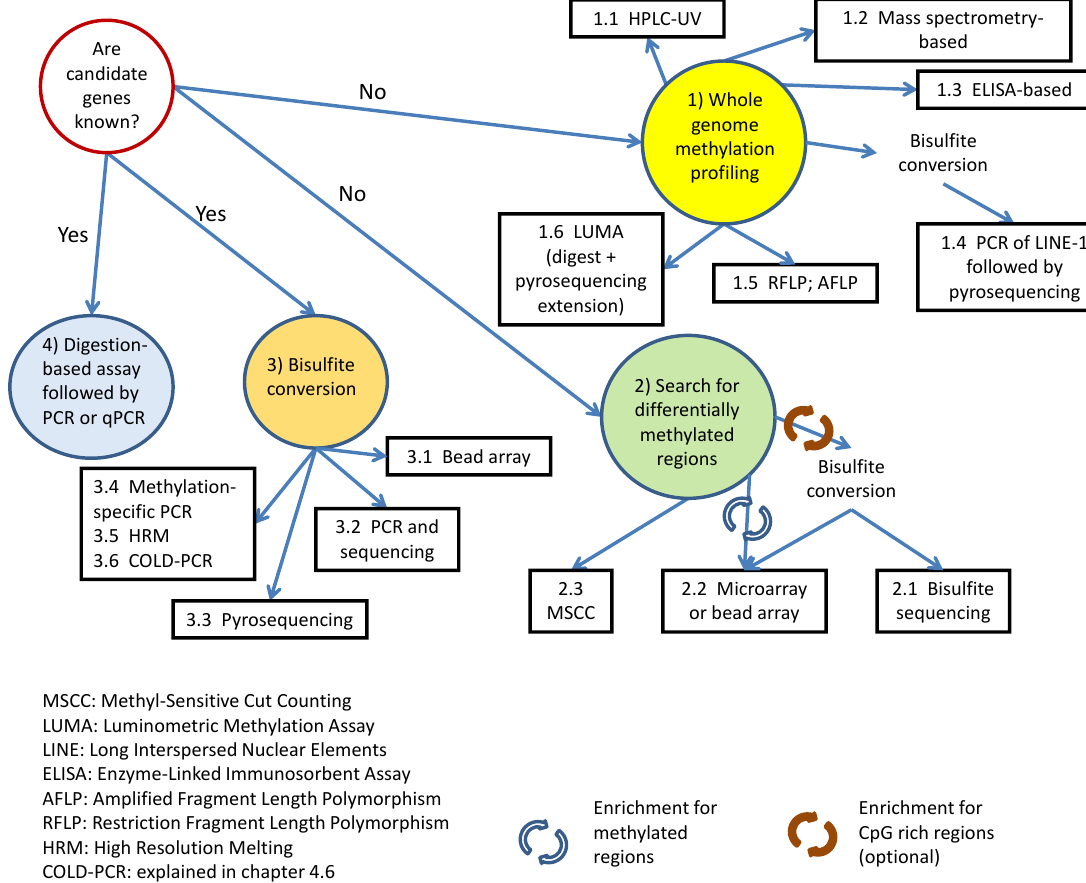
Figure 1. Algorithm for choosing a suitable method for DNA methylation analysis.